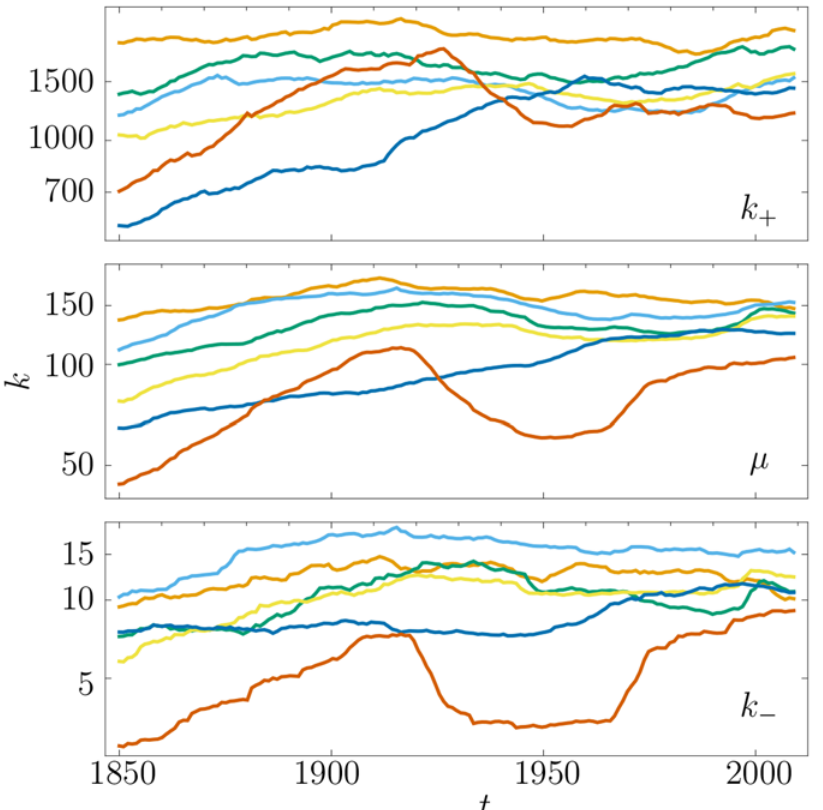
Fig 3. Evolution in time of the center of the sigmoid (middle panel), and the borders of the head and body (bottom panel) and body and tail (top panel) for the different languages along time for intervals of fifty years, i.e. Δ t = 50. Head words have k (cid:5) k − , body words have k − < k (cid:5) k + , and tail words have k + < k . See Fig. 2 for color